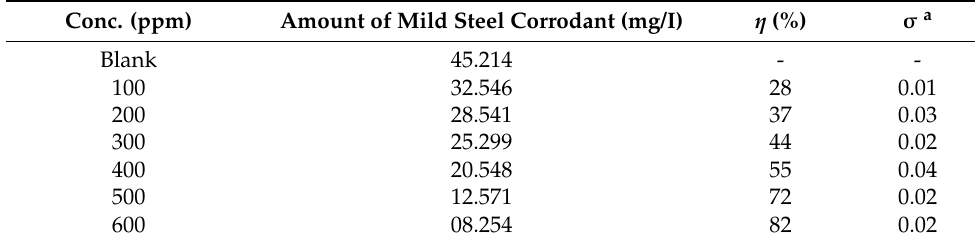
Table 3. AAS study for different concentrations of C. tagal extract in 1 M HCl (303 ± 1 K). Conc. (ppm) Amount of Mild Steel Corrodant (mg/I) η (%) σ a Blank 45.214